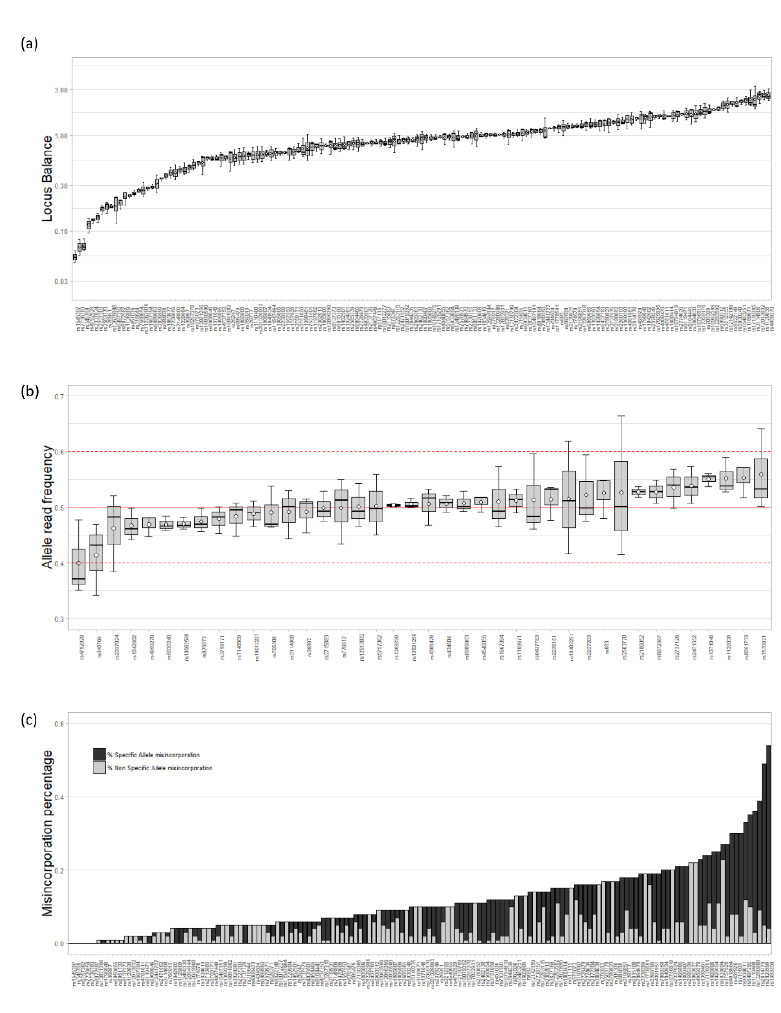
Figure 2. Sequencing parameters obtained with the VISAGE BT A&A (PSeq) assay from the analysis of the three replicates of 2800 M Control DNA at 0.5 ng. ( a ) Distribution of the locus balance. ( b ) Distribution of the allele read frequency of every heterozygote locus of 2800 M Control DNA. A continuous line marks the expected optimum (0.5) while the dotted lines indicate the lower and upper thresholds (0.4 and 0.6, respectively). ( c ) Distribution of base misincorporation percentage, showing the percentage of specific (SBM) and non-specific (NBM) base misincorporations for each locus.